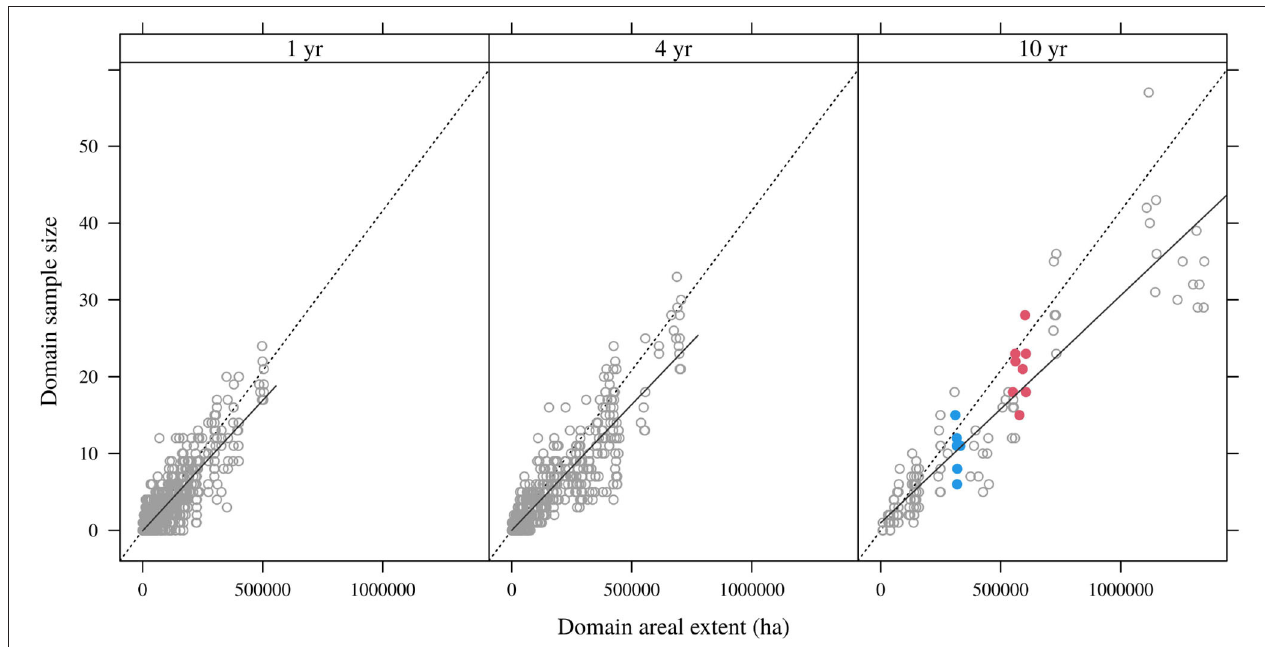
FIGURE 2 | Domain sample sizes and areas for annual, quadrennial, and decadal domains, showing data for all lags. Dotted line is the nominal FIA sampling intensity; solid lines are linear regressions for particular lag buffers. Red symbols denote various lags for the OR 2000–2009 domain; blue symbols denote estimable lags for the ID 1990–1999